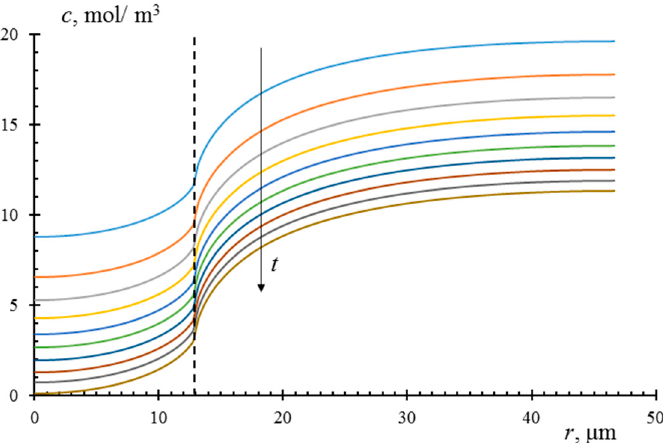
Figure 17. Distribution of electrolyte concentration in the DBL at a heterogeneous membrane surface, calculated using the 3D model [303] at i = 1.25 i lim in moments of time 0.2, 0.8, 1.4 . . . 5.6 s. The parameters used in simulation relate to a membrane with randomly distributed conductive areas with the radius of 12.95 µ m, the fraction of the conductive surface area γ = 0.077, the DBL thickness δ = 260 µ m. The centre of the conductive area refers to r = 0, the boundary between the conductive and non-conductive regions is shown with the dashed line. Reproduced with permission from [314], Elsevier, 2018.